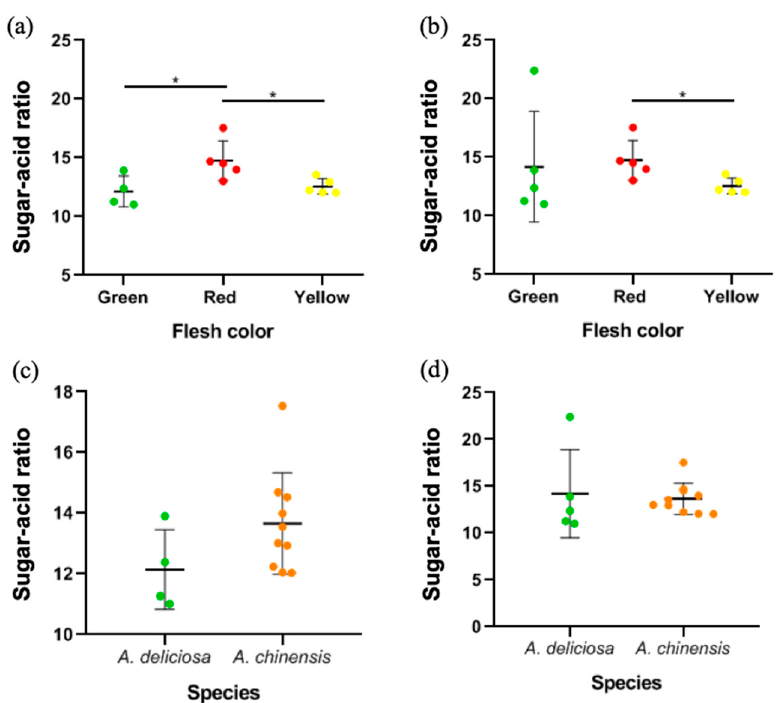
Figure 3. ( a ) The distribution of sugar-acid ratio in different flesh colors of 14 cultivars, which is not included the cultivar “Ruiyu”. ( b ) The distribution of sugar-acid ratio in different flesh colors of 15 cultivars. ( c ) The distribution of sugar-acid ratio in two species of 14 cultivars, which is not included the cultivar “Ruiyu”. ( d ) The distribution of sugar-acid ratio in two species of 15 cultivars. Mean values in each column with “*” are significantly different ( p < 0.05).